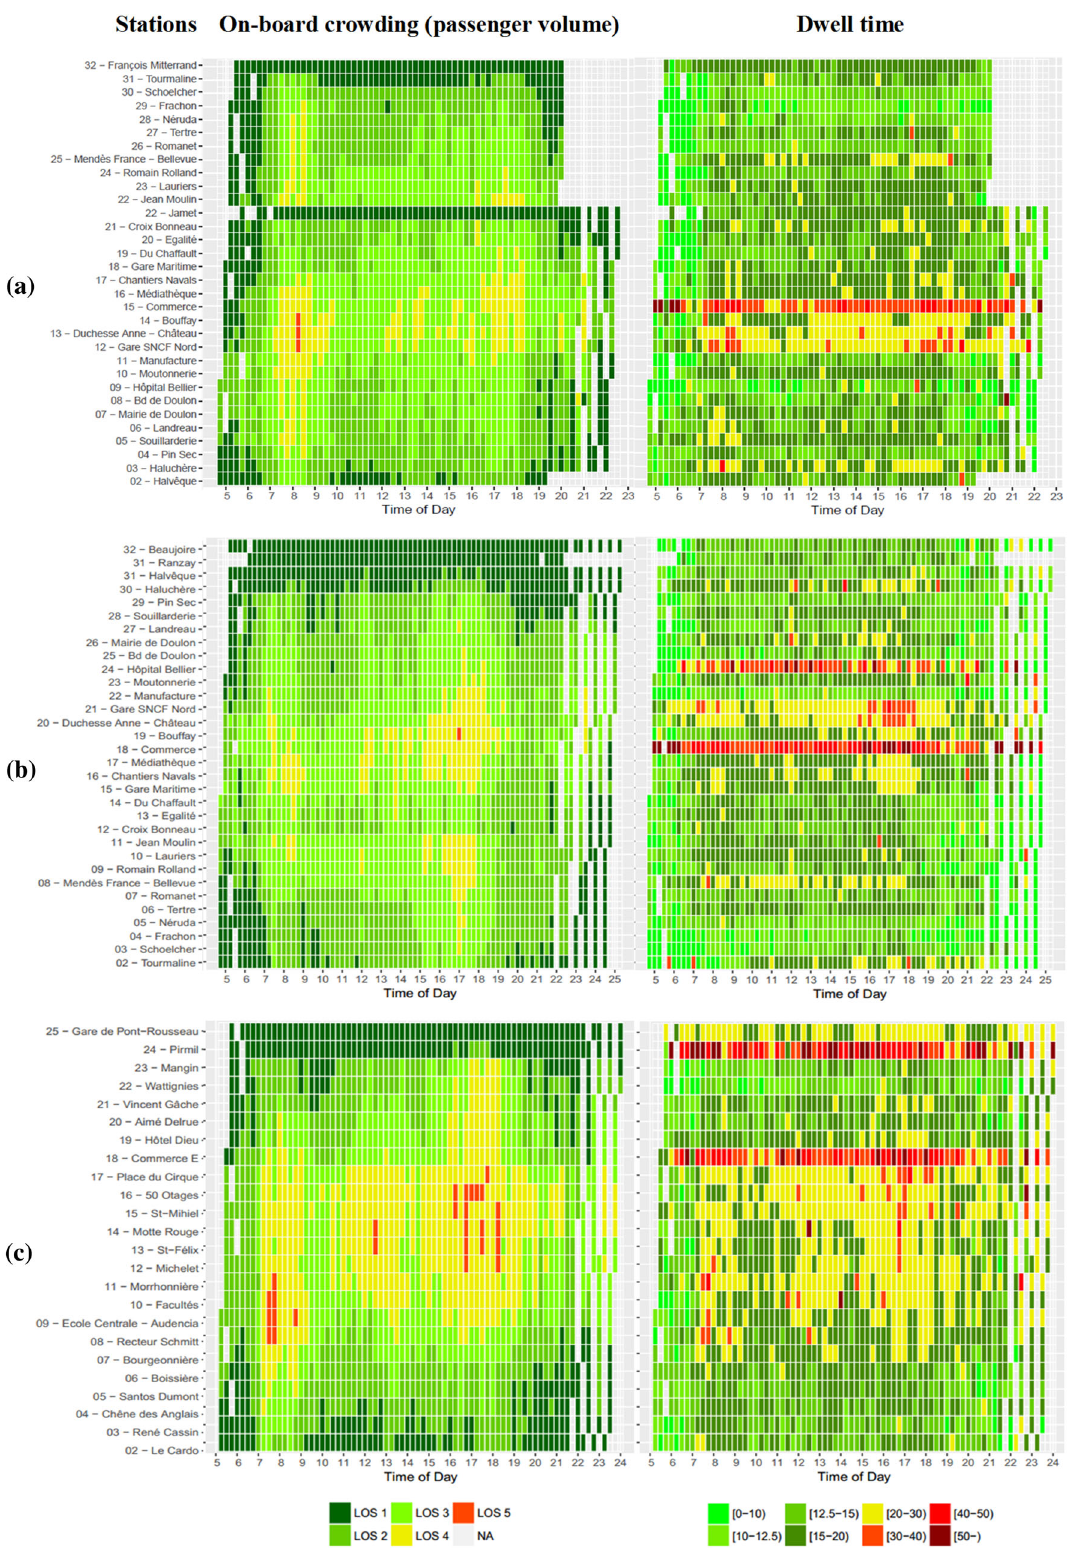
Fig. 2 Dwell time heat maps for each line and direction: a Line 1 westbound. b Line 1 eastbound. c Line 2